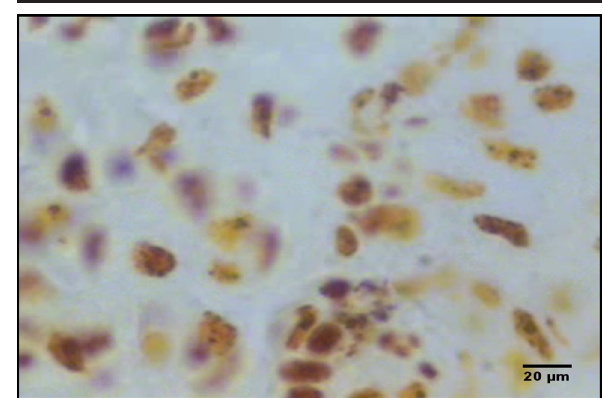
FIGURE 4 - Lung slice from an animal for the 10/21 experimental group. AgNOR dots are scarce and do not get into groups. (AgNOR method, original magnification X